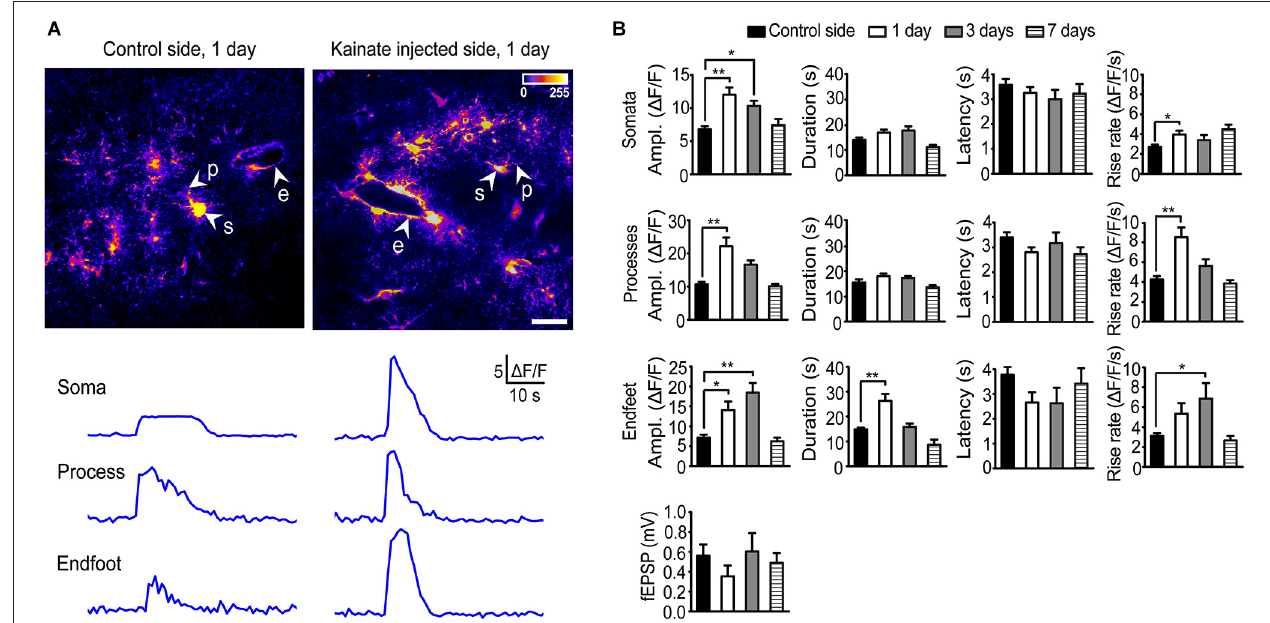
(B) Amplitudes, duration, latency and rise rate of Schaffer collateral/commissural fiber (Scc) stimulation (20 Hz, 10 s) evoked GCaMP5E fluorescence transients in astrocytic somata, processes and endfeet in control (non-injected side; 20 mice, 22 slices), 1 day (11 mice, 16 slices), 3 days (3 mice, 6 slices) and 7 days (6 mice, 9 slices) after kainate injection. Lower panel shows average fEPSP for the different time points. Values are mean ± s.e.m. Asterisk, P < 0.05. Double asterisk, P <